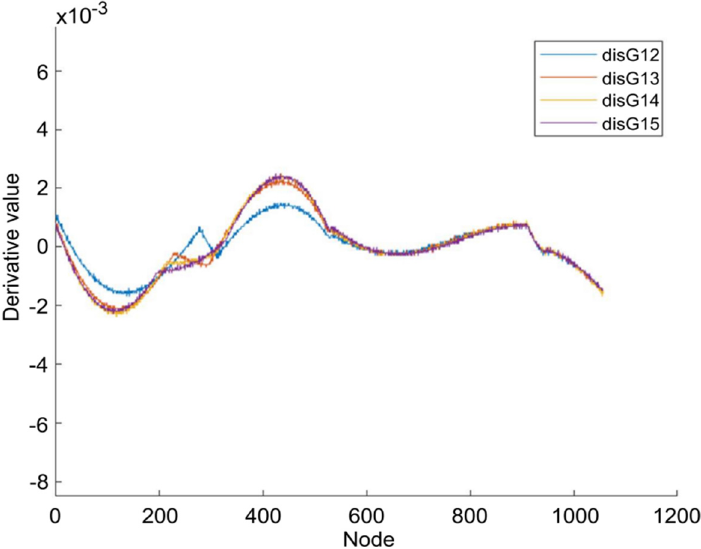
Figure 30. First-order derivatives of first-order mode differences under Conditions 1, 4, 5, 6 and 7.